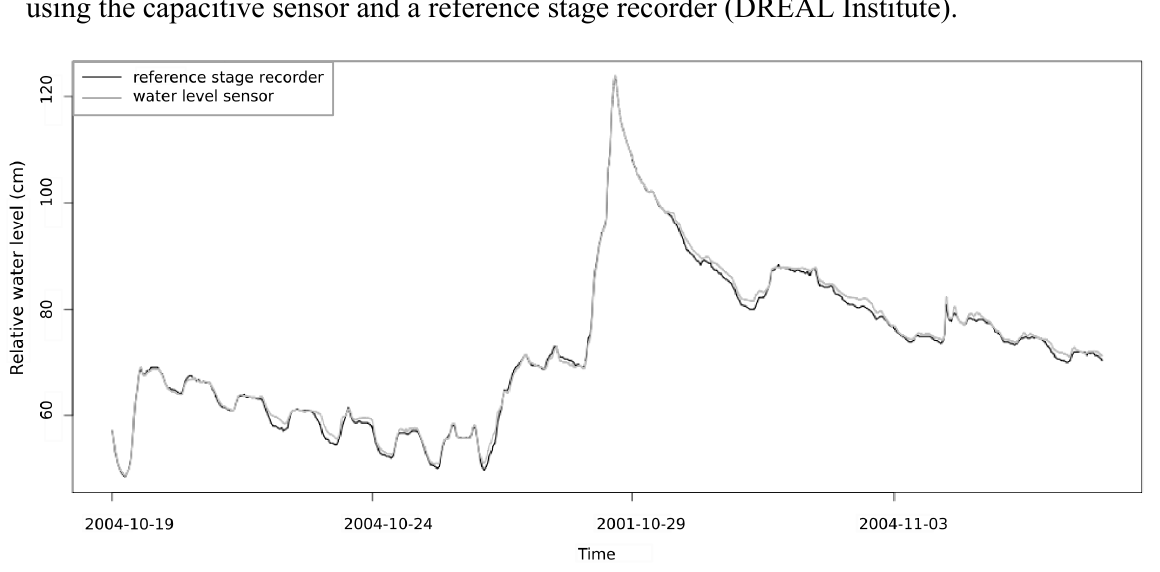
Figure 6. Stage recorder field test carried out at the Lez catchment. Comparison, over a period of sixteen days with a 3-minute data acquisition step, between the stage recorder using the capacitive sensor and a reference stage recorder (DREAL Institute).